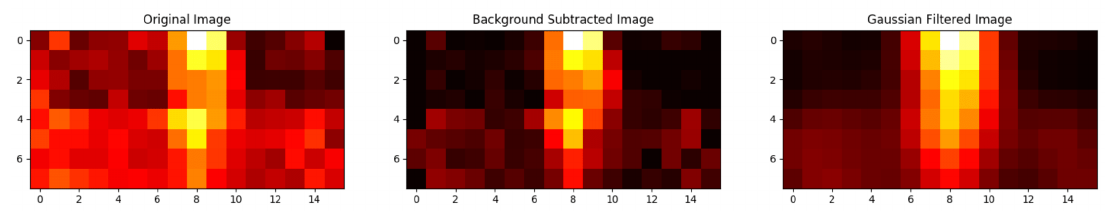
Figure 7. Data pre-processing. ( left ) original thermal sensor frame; ( middle ) background subtracted thermal sensor frame; ( right ) smoothed frame with Gaussian Kernel.